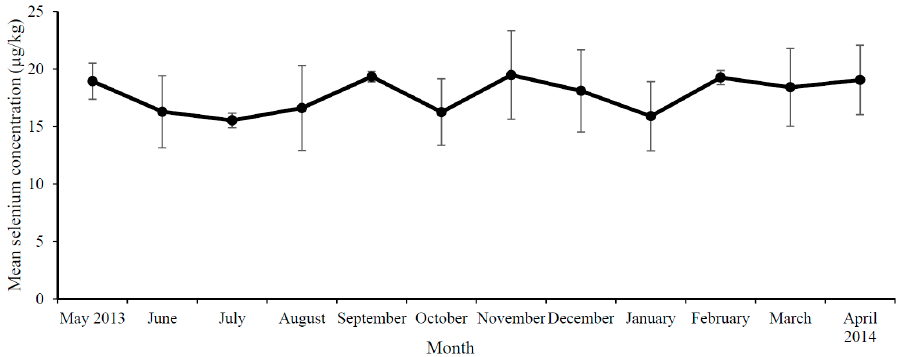
Figure 2. (Mean ± standard deviation (SD)) Selenium concentration of NI milk (combined skimmed, semi-skimmed and whole) according to month of collection. Table 1. Iodine and selenium concentrations according to milk fat class, pasteurisation and season.